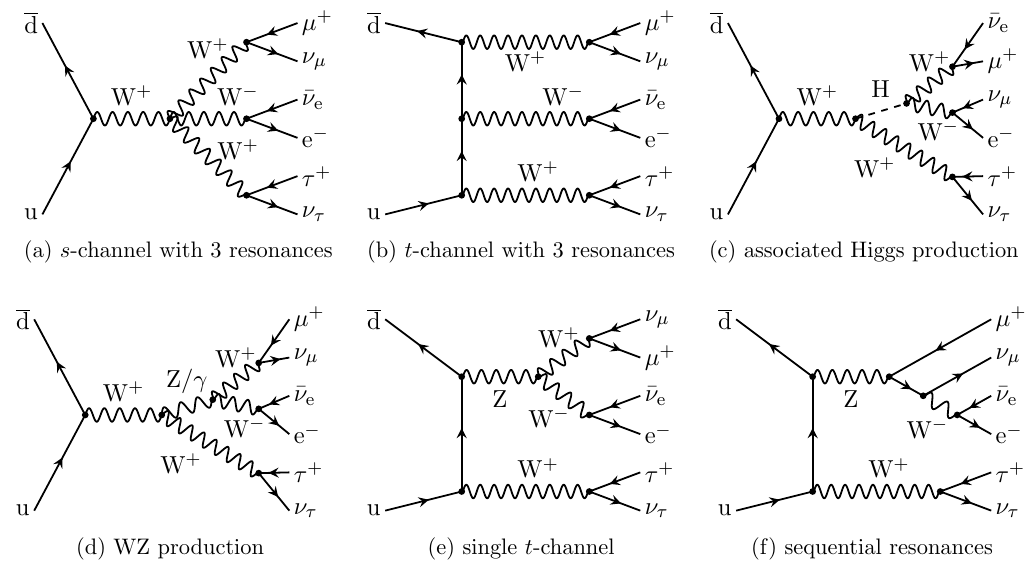
Figure 1. Examples of LO Feynman diagrams contributing to pp ! e (cid:0) (cid:22) (cid:23) e (cid:22) + (cid:23) (cid:22) (cid:28) + (cid:23) (cid:28) + X . production of the three W bosons, already at LO triple and quartic gauge vertices